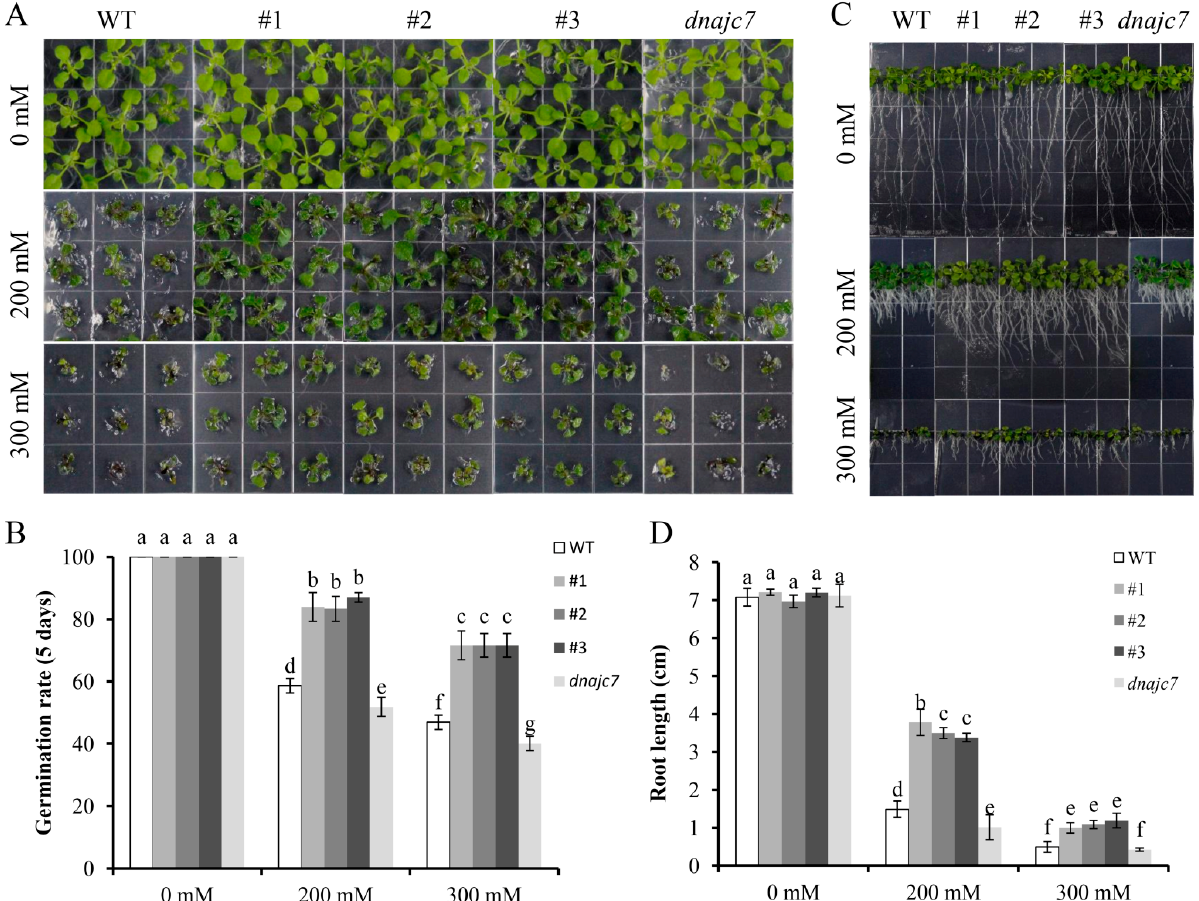
Figure 8. The effect of GmDNAJC7 ectopic expression on Arabidopsis tolerance to mannitol treatment. ( A ) Seed germination assay of different Arabidopsis lines on 1/2 MS agar plates and 1/2 MS supplied with various concentrations of mannitol. Photographs were taken 10 days after mannitol treatment. WT: wild type; #1, #2, #3: Arabidopsis lines overexpressing GmDNAJC7; dnajc7 : Arabidopsis mutant. ( B ) Seed germination rates after five days for different Arabidopsis lines as shown in A. ( C ) Phenotypes of Arabidopsis lines subjected to 0, 200, and 300 mM mannitol treatment for 10 days, respectively. ( D ) Root length of Arabidopsis lines as shown in ( C ). Root lengths were analyzed using ImageJ software. Bars represent the mean values ± standard deviations of three independent experiments and each repeat contained at least four independent plants per line for each treatment ( n ≥ 12). Bars with the same letters in lowercase above bars indicate no significant differences at the 0.05 level